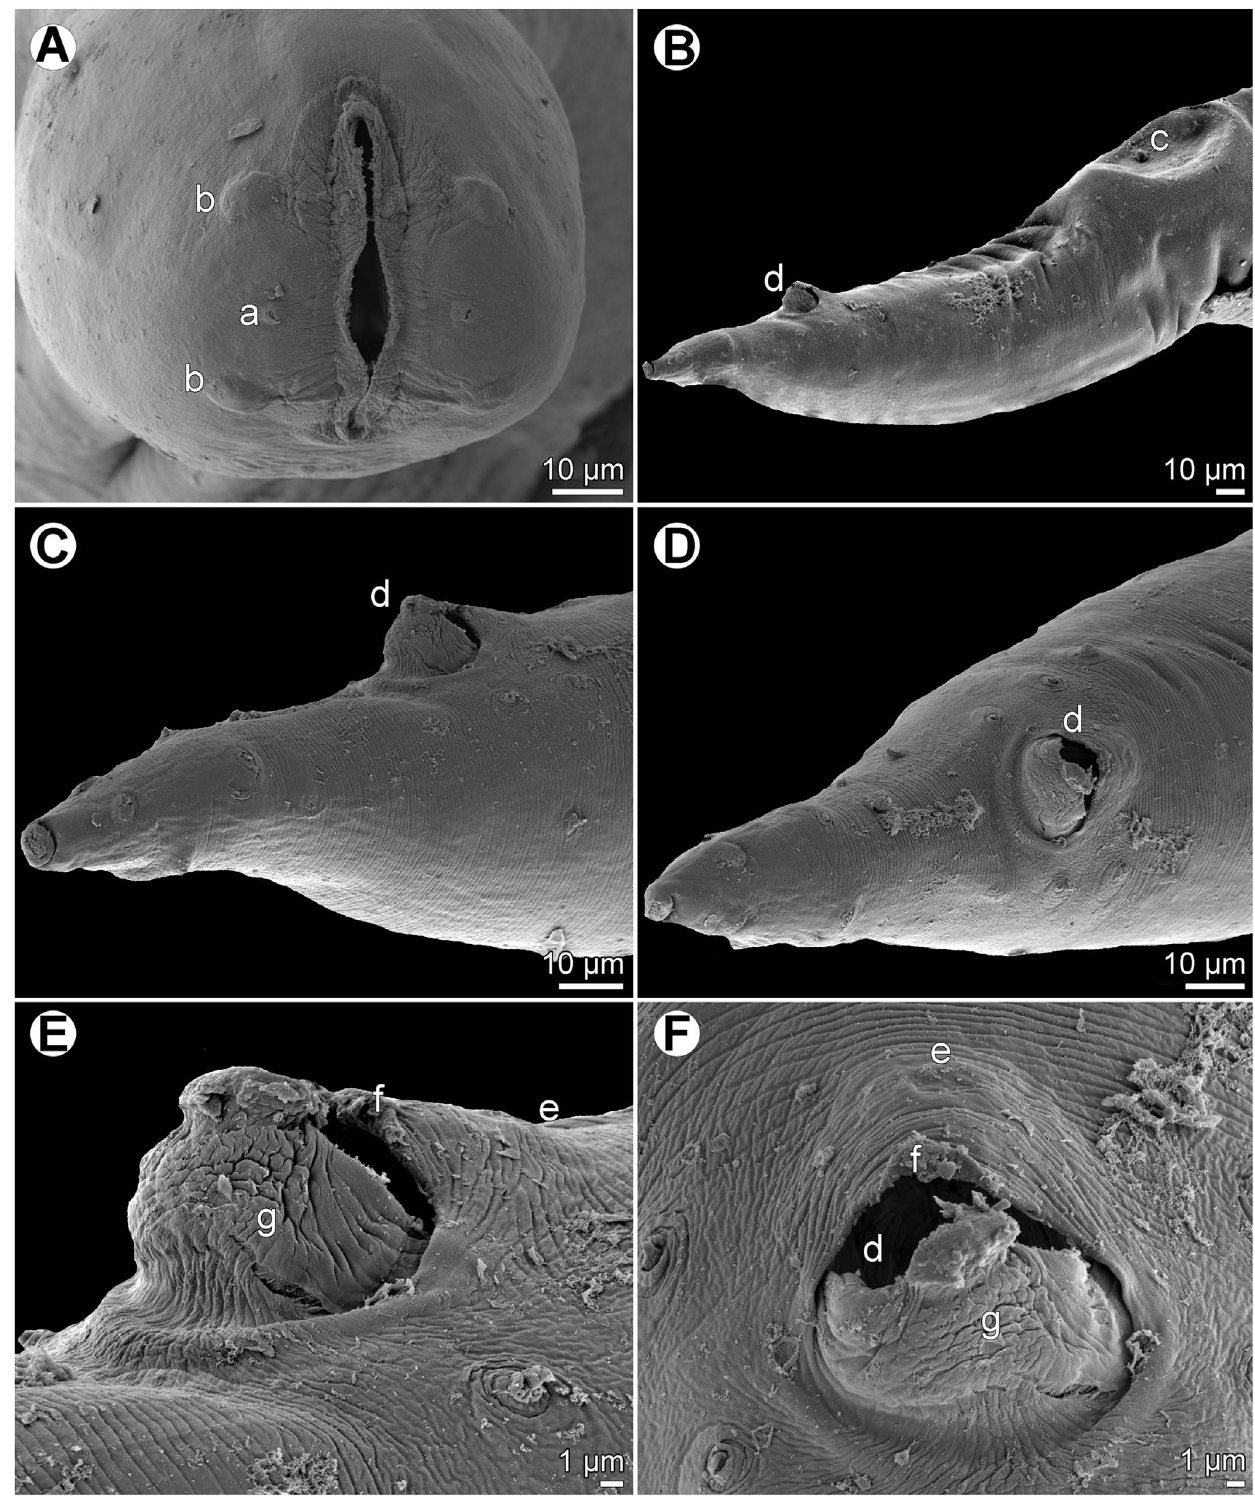
Figure 10. Cucullanus parapercidis n. sp., scanning electron micrographs of male from Parapercis xanthozona . (A) Cephalic end, apical view; (B) posterior end of body, lateral view; (C, D) tail, lateral and ventral views, respectively; (E, F) region of cloaca, lateral and ventral views, respectively. (a) Amphid; (b) cephalic papilla; (c) ventral sucker; (d) cloacal aperture; (e) precloacal median elevation; (f) outgrowth of anterior cloacal lip; (g) posterior cloacal lip with apical